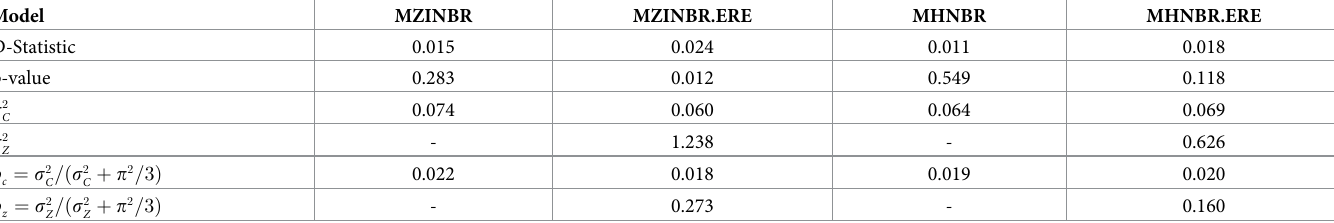
Table 5. DHARMa Uniformity Test for the mixed-effect zero-inflated negative binomial (MZINBR), MZINBR with extra random effects in the zero part (MZINBR.ERE), mixed-effect hurdle negative binomial (MHNBR), and MHNBR with extra random effects in the zero part (MHNBR.ERE) models (p-value < 0.05 indicates the model doesn’t fit well for the count data) and the corresponding count-part ( σ 2 correlation